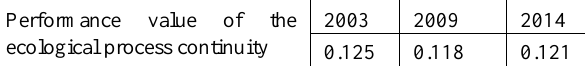
Table 2. Performance value of the ecological process continuity in Guyuan during 2003-2014